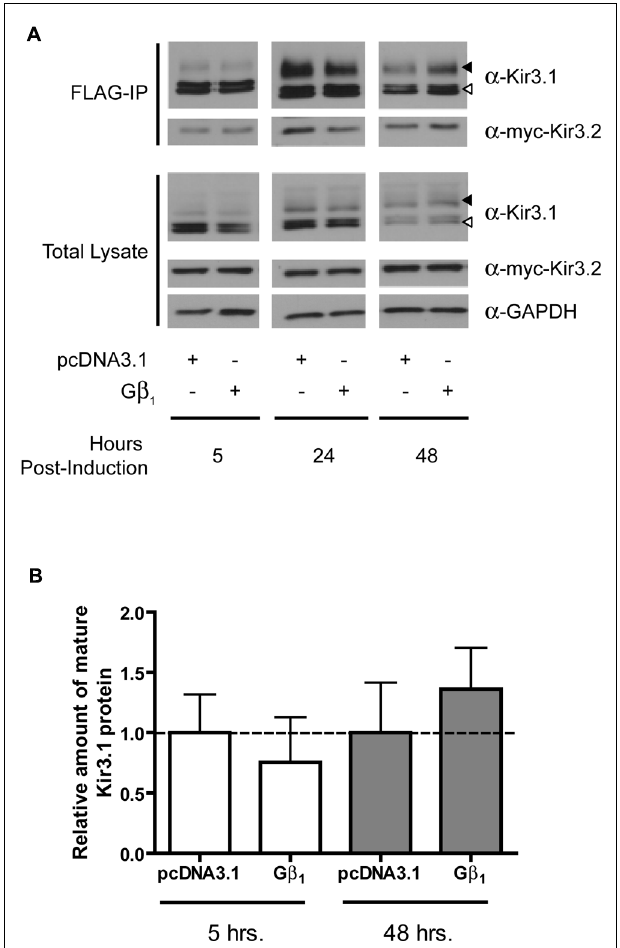
FIGURE 2 | Overexpression of G β 1 stabilizes Kir3.1. (A) Flp-InTrex FLAG-Kir3.1 cells co-expressing G β 1 and myc-Kir3.2 were induced to express FLAG-Kir3.1 with 1 μ g/mL of tetracycline for 30 min followed by chase times of 5, 24, or 48 h. Cells were lysed and FLAG-Kir3.1 was immunoprecipitated as described above. Upper panel: samples were analyzed by western blot to detect levels FLAG-Kir3.1 and myc-Kir3.2. Lower panel: total cell lysates showing expression of Kir3.1, Kir3.2, and GAPDH (loading control). Results are representative of two independent experiments.White arrow indicates immature channel proteins while black arrow indicates correctly processed Kir3.1. (B) Densitometric analysis of results obtained above.There is a trend in the effects of G β 1 expression at 48 h, which is reflected in the western